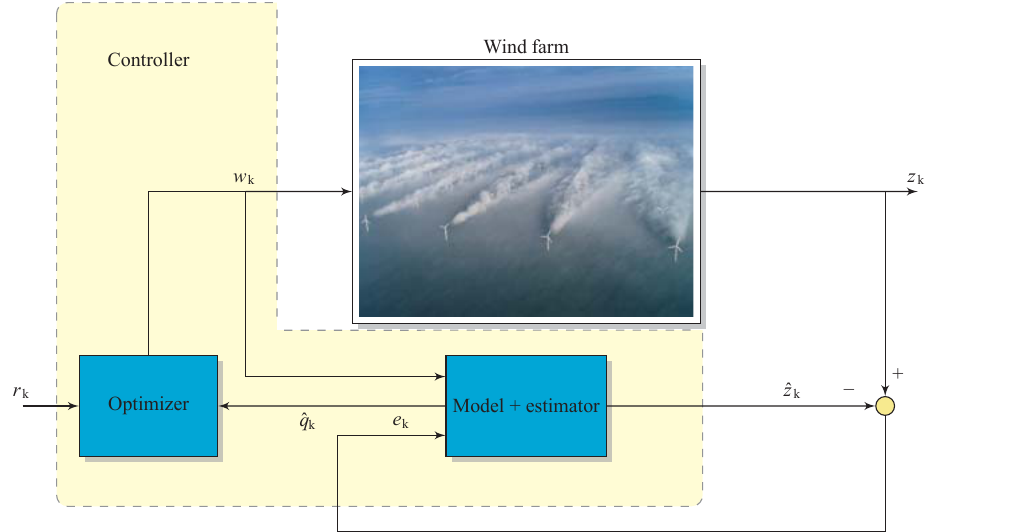
Figure 1. General dynamical closed-loop control framework with measurements z k and its estimation ˆ z k and state estimation ˆ q k . The signals r k and w k are reference and control signals, respectively. In this paper we present a dynamic model that is compatible with this